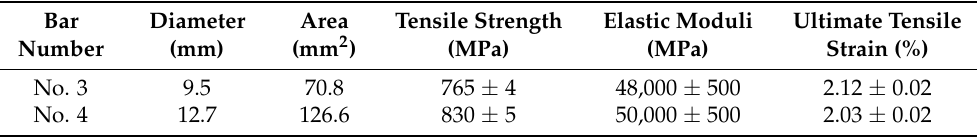
Table 3. Different features of GFRP bars.